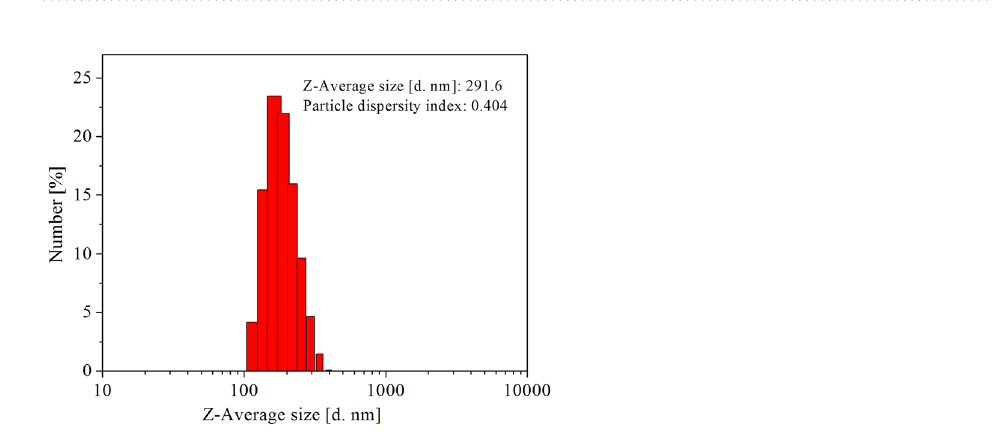
Figure 7. DLS of MHCO/GPTMS-ZnO composites.